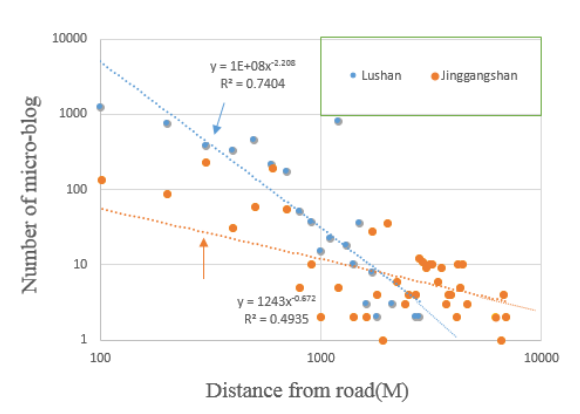
Figure 6. The number of microblogging within a certain distance from the road and the power-law relationship between